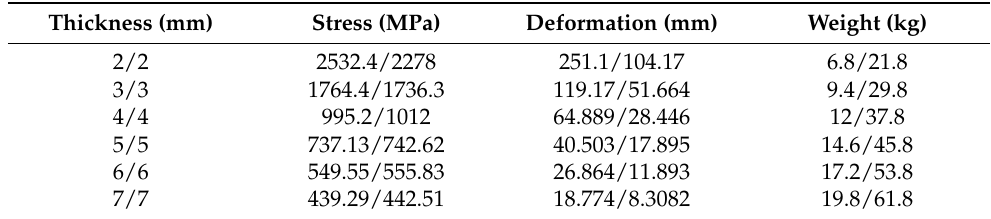
Table 4. Stress and displacement of varied thickness bumper with S2 glass fiber epoxy material and steel material at 8 kmph (S2 glass fiber